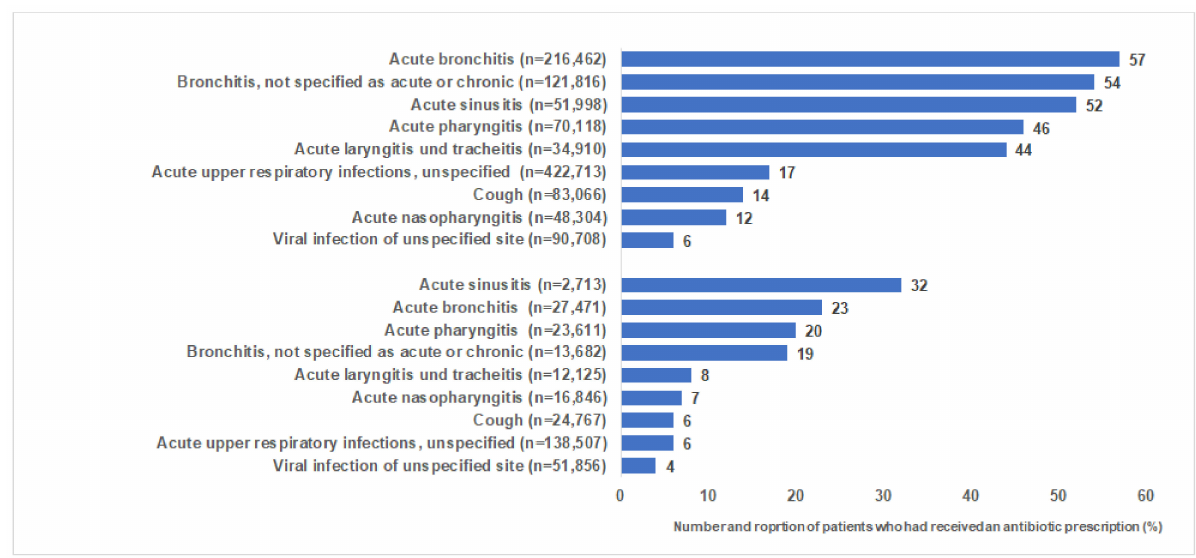
Figure 2. Proportion of patients who had received an antibiotic in general practices (GP) and pediatric